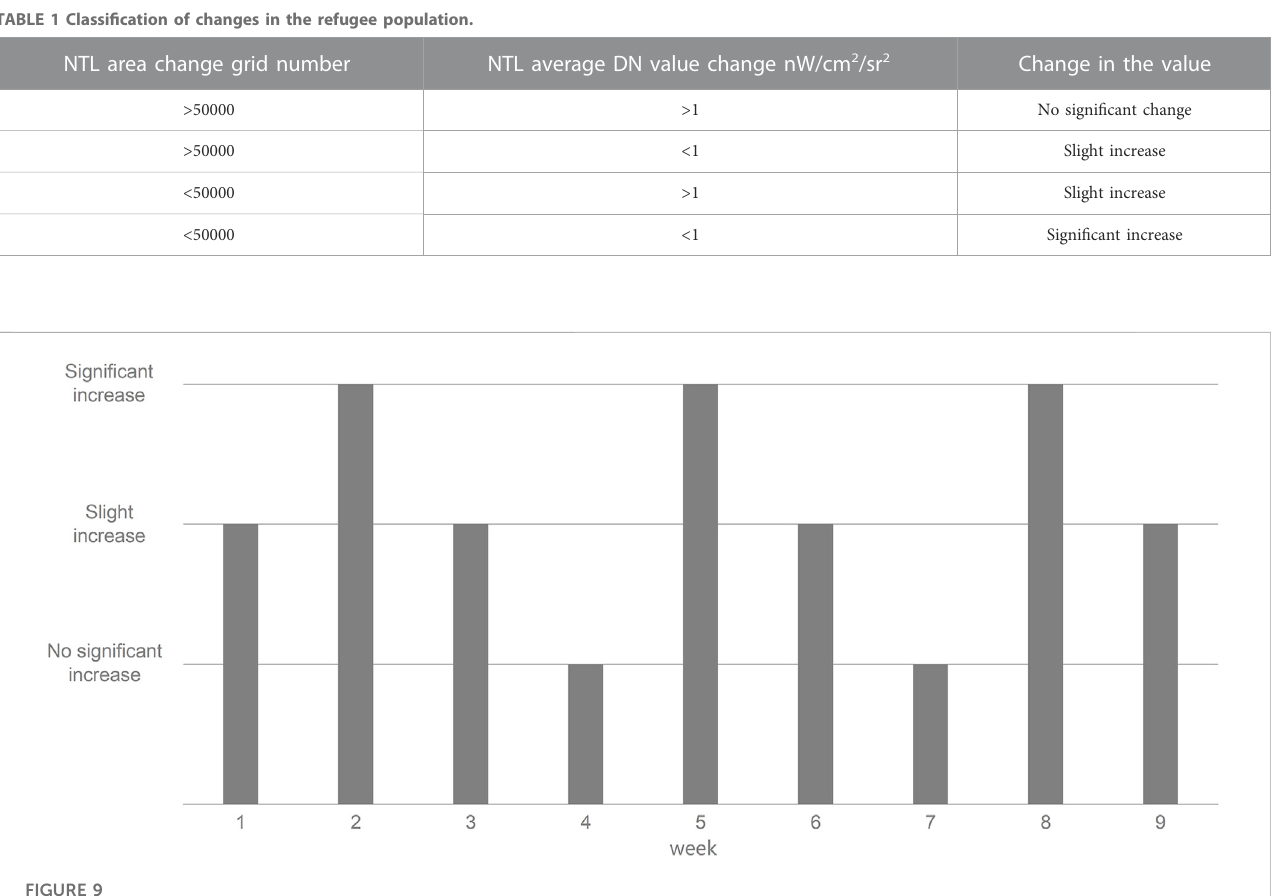
Frontiers in Environmental